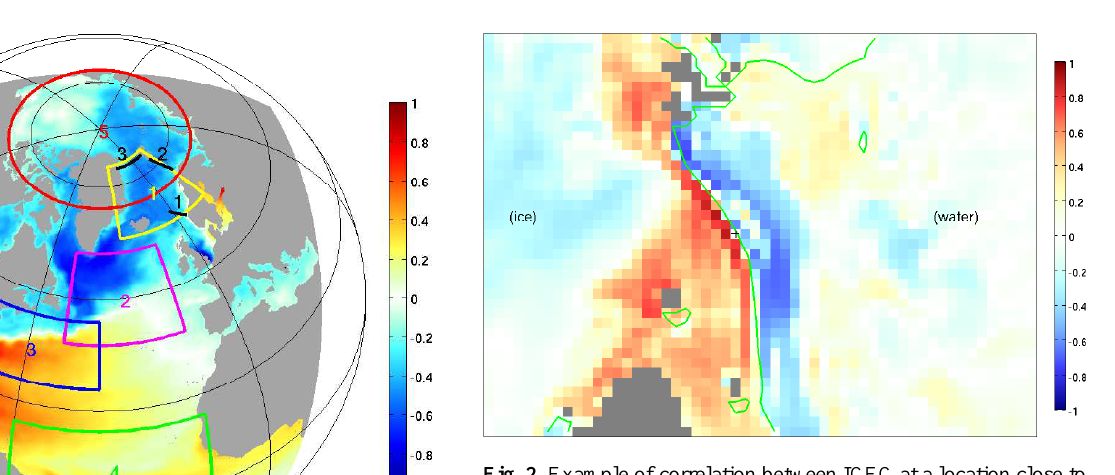
Fig. 2. Example of correlation between ICEC at a location close to the ice edge (marked “+”) and sea surface salinity. Calculated from TOPAZ ensemble in the course of the reanalysis for a location in Barents Sea on 27 June 2007. The green contour line corresponds to ICEC of 0.2 (20%); the area to the left of it is covered by ice, while the area to the right is ice free. Land cells are shown in grey